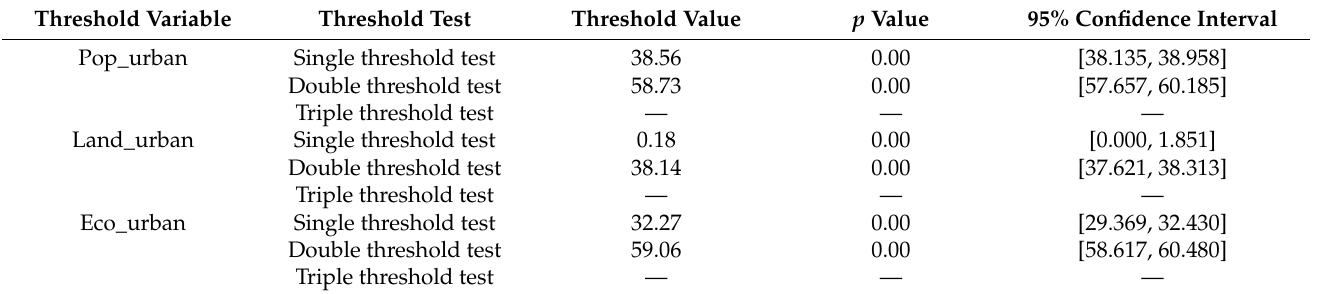
Table 6. Threshold estimates and test results.